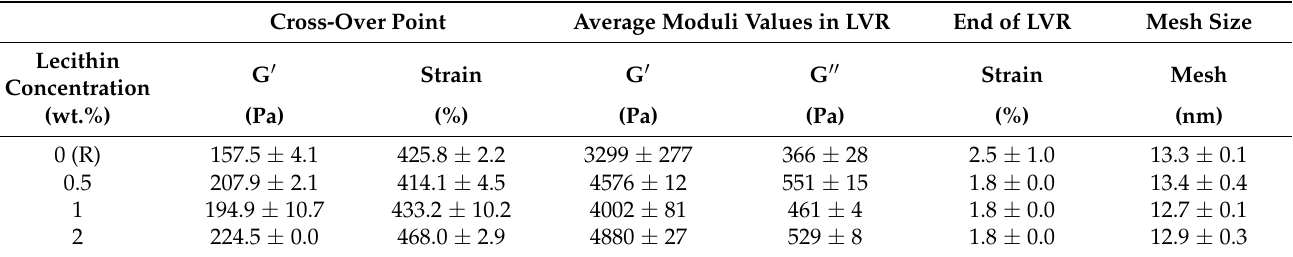
Table 1. Values for physically crosslinked agarose hydrogels after preparation obtained from strain and frequency sweep tests before